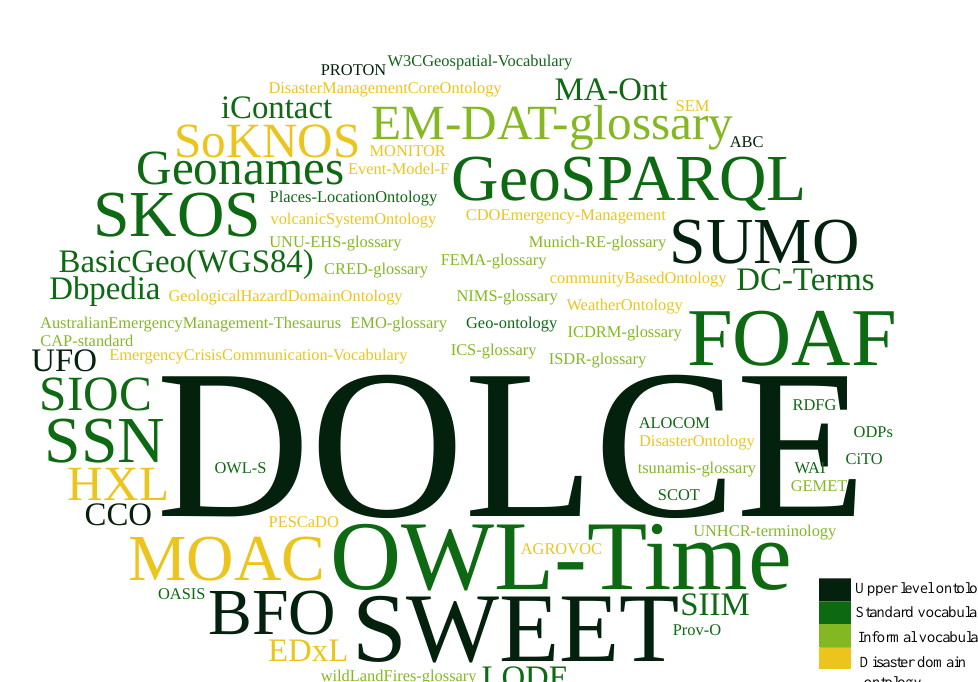
Figure 5. Tag Cloud of Reused Vocabularies for Creating Ontologies within the Disaster